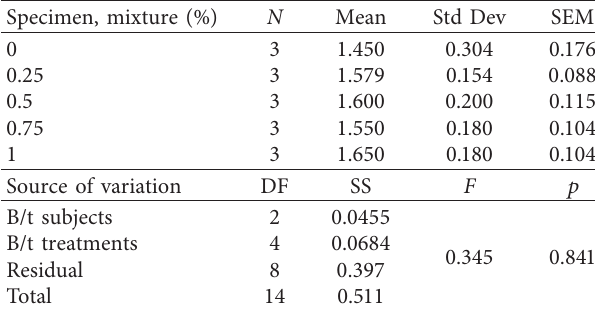
Figure 6: Tensile strength of specimens. Table 4: Descriptive and One-Way RM ANOVA of tensile